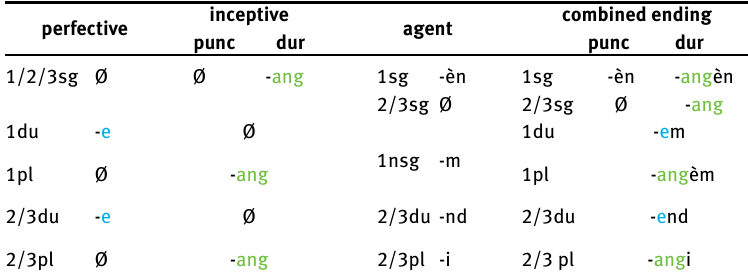
Table 7: Immediate inceptive